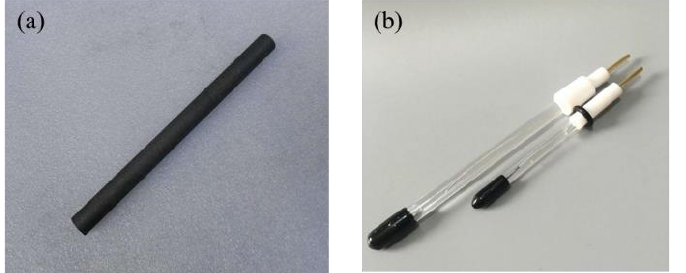
Figure 2. The current electrode and potential electrode. ( a ) Graphite current electrode; ( b ) Ag/AgCl nonpolarized potential electrode.